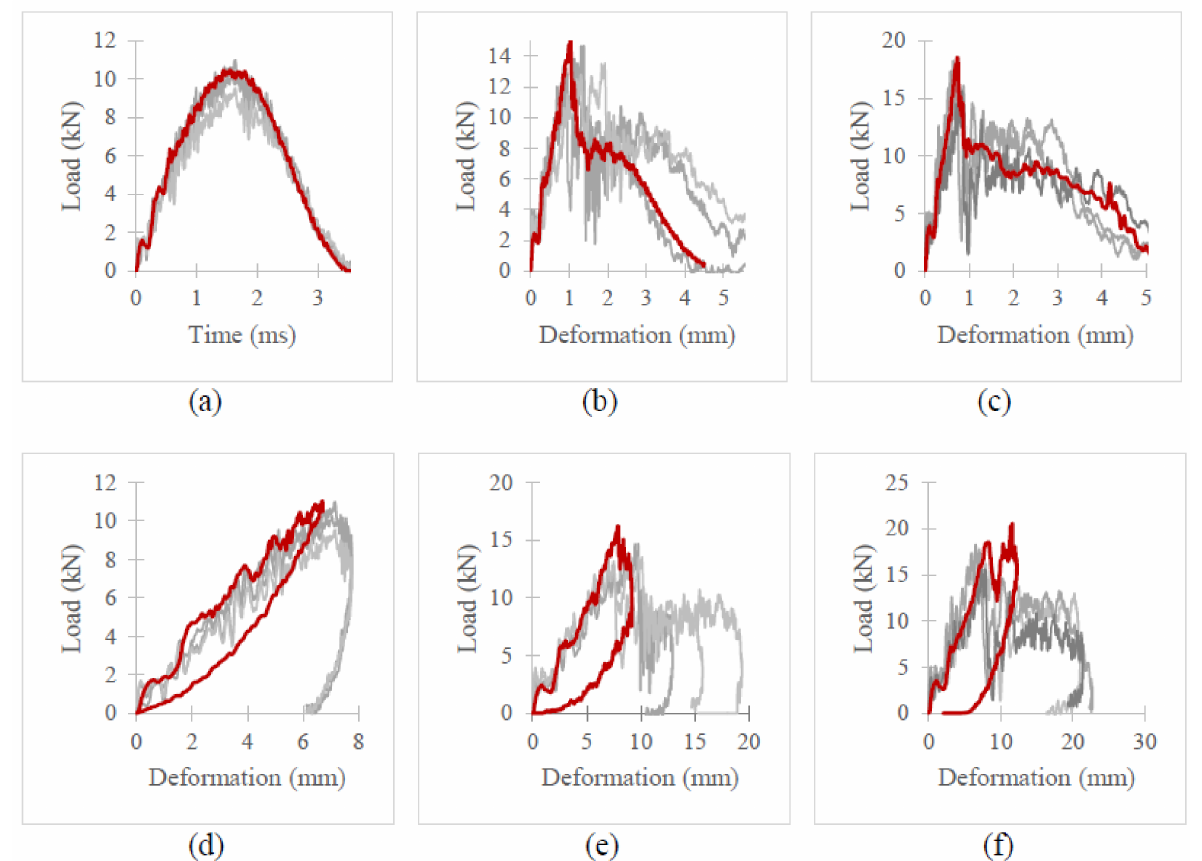
Figure 15. Force–time histories ( a – c ) and force–displacement curve ( d – f ) for T700/PPS at 40, 100 and 160